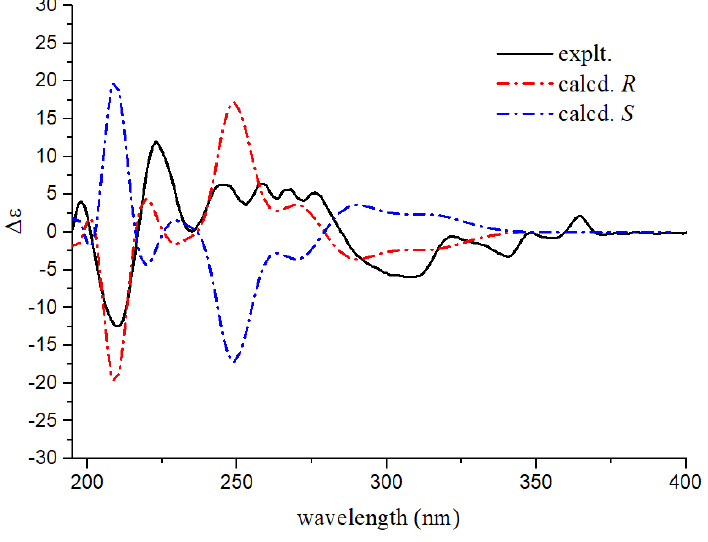
Figure 3. Calculated ECD spectra and experimental curve of 1.